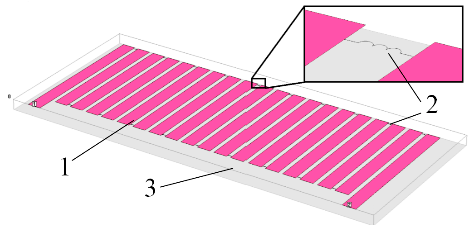
Figure 3. Meander system with inductive components in the peripheral parts, where 1 = central meander electrode; 2 = peripheral helical turns of electrode; and 3 = dielectric substrate.